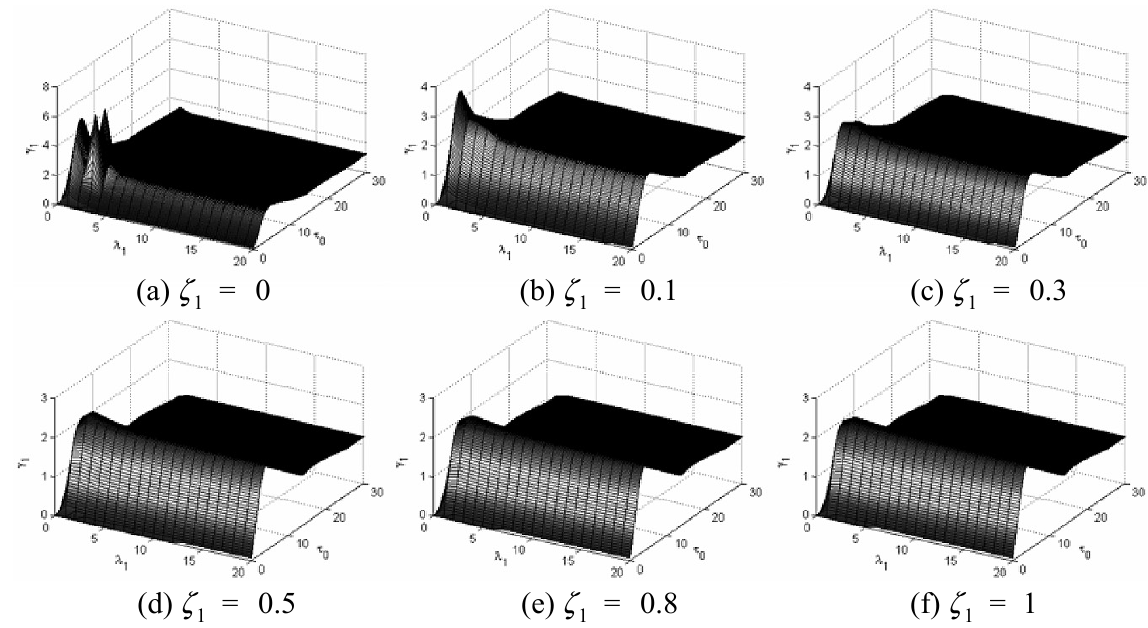
Fig. 6. Effect of damping ratio of critical component ( ζ 1 ) on three-dimensional shock spectrum of critical component. Here, λ 2 = 0 . 1 , ζ 2 = 0 .